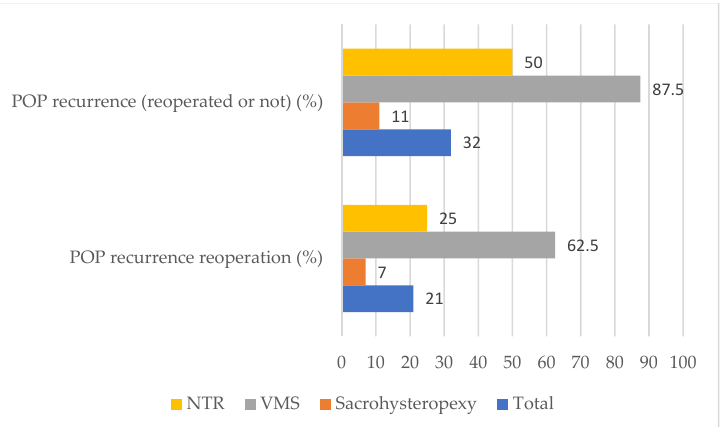
Figure 1. Flow chart.